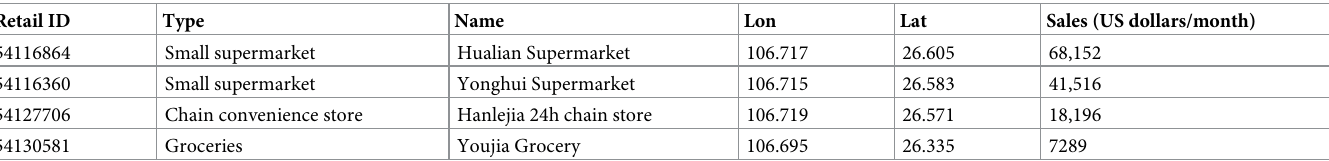
Table 1. Examples of consumption